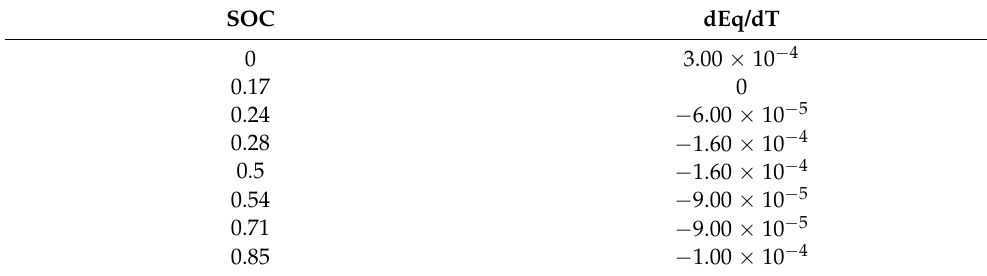
Table 4. Open circuit partial derivative with respect to temperature for the graphite anode.